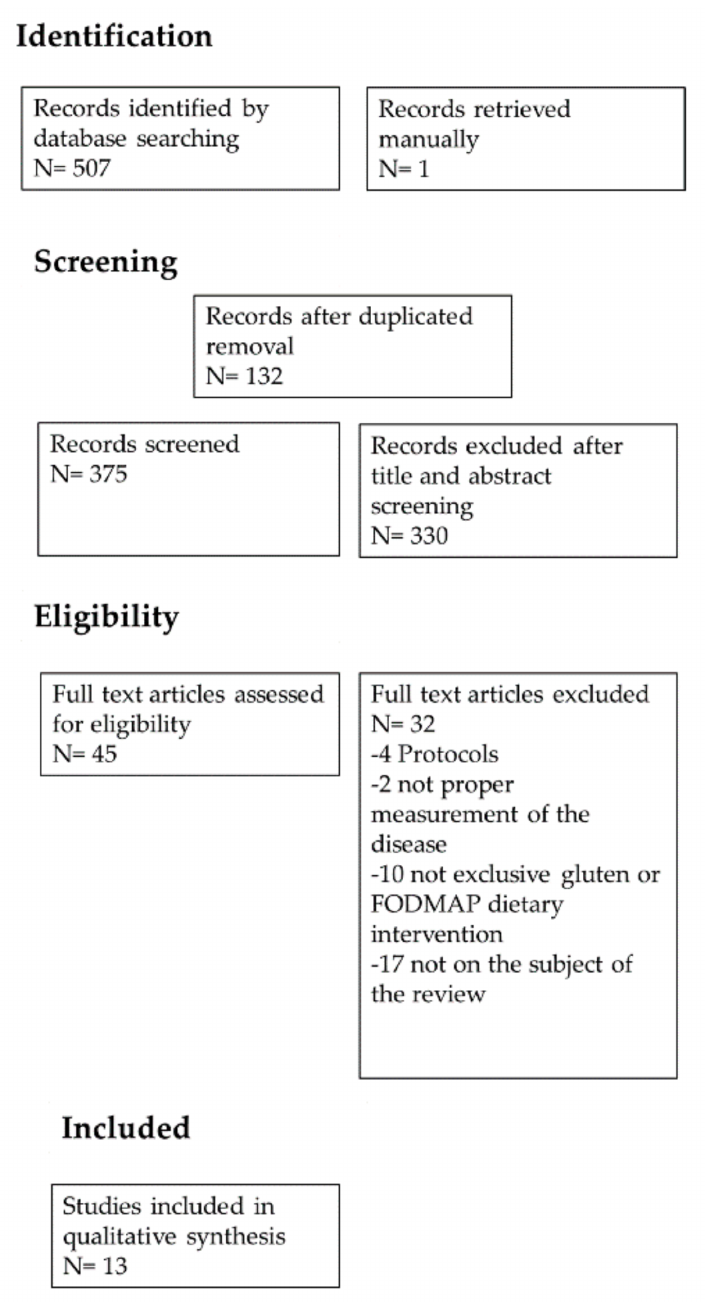
Figure 1. PRISMA flow chart: summary of evidence search and